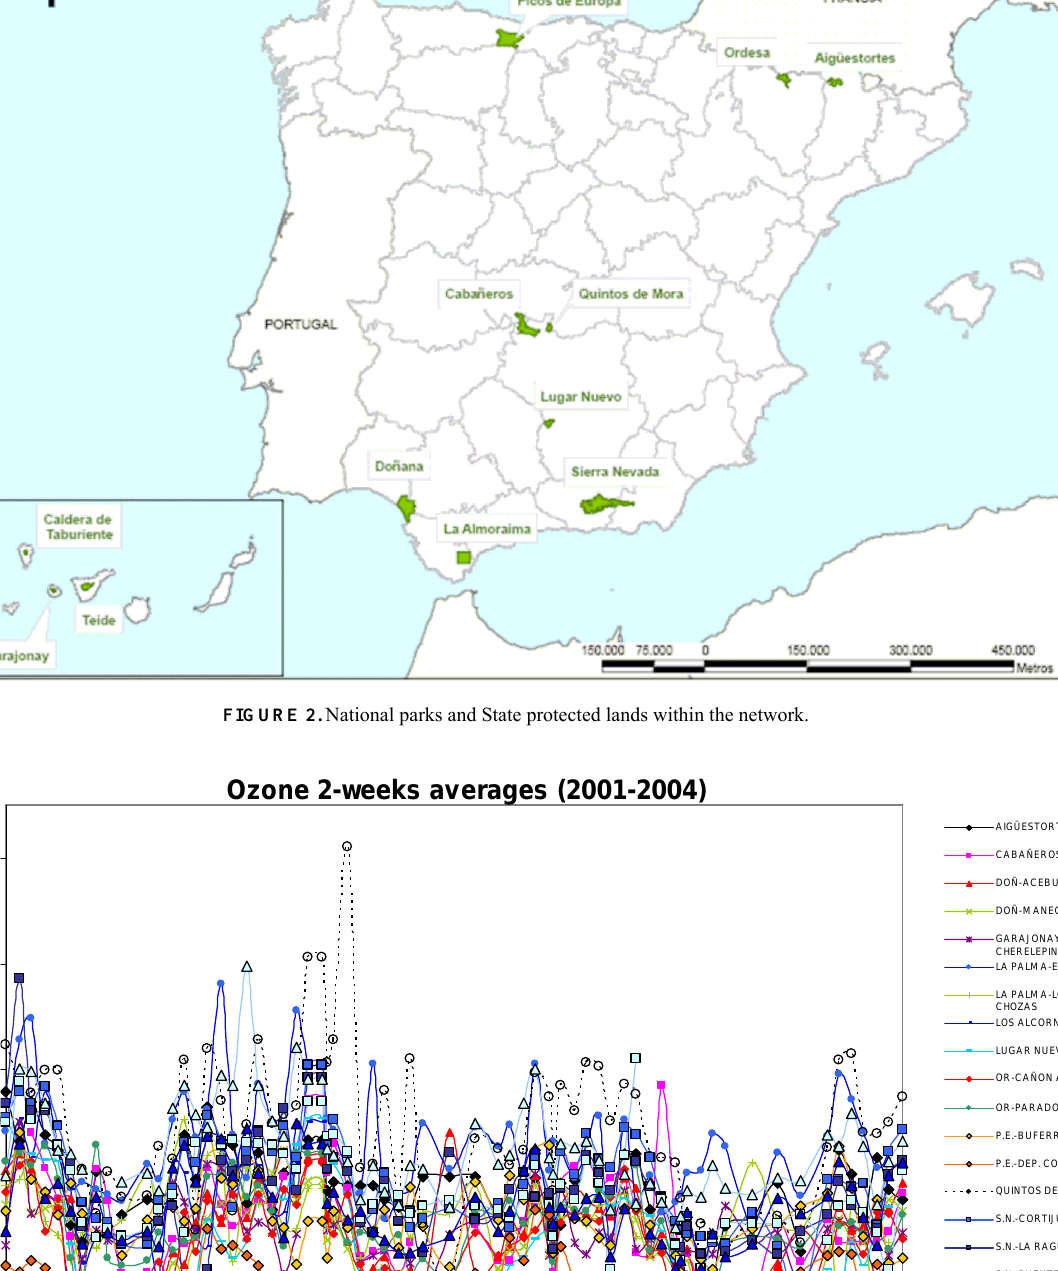
FIGURE 3 . Biweekly averages for the 3 years (July 2001–July 2004) for all